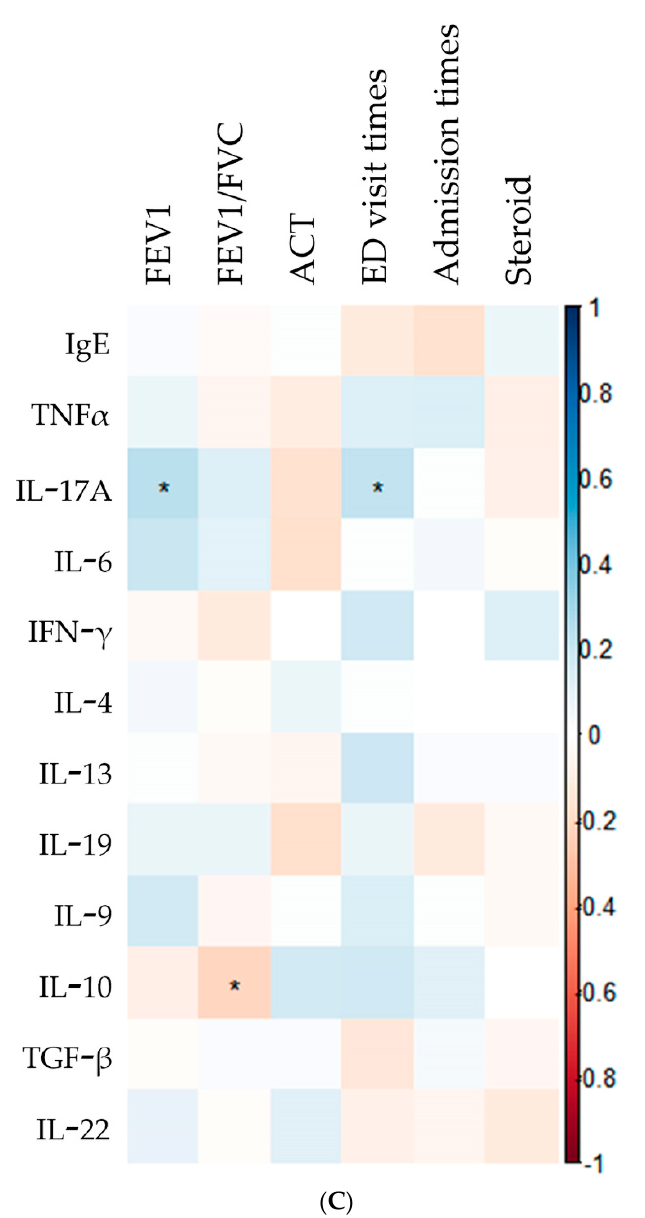
Figure 1. Correlation matrix plot between ( A ) fungus and asthma-related outcomes, ( B ) inflamma- tory cytokine and asthma-related outcomes, and ( C ) fungus and inflammatory cytokine. * p < 0.05, ** p < 0.01, *** p < 0.001 .